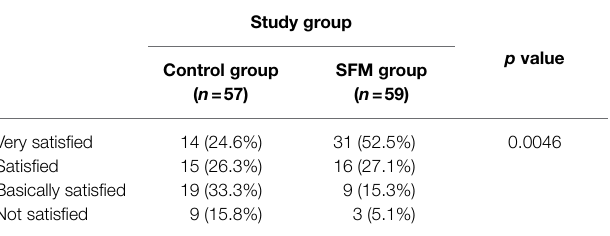
TABLE 2 | Comparison of satisfaction of the care between the two